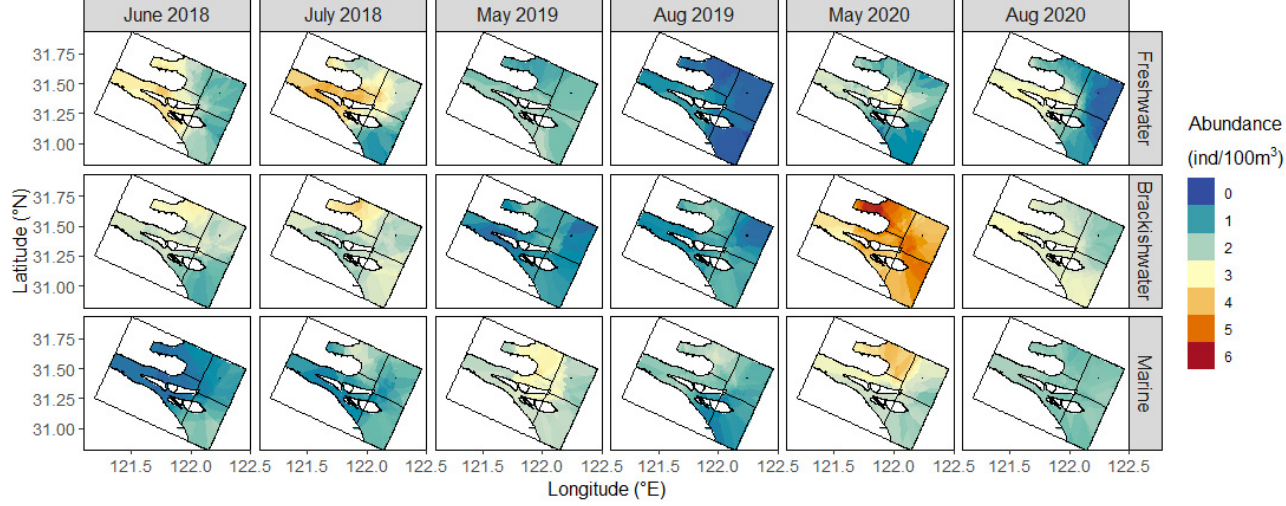
Figure 7. The distribution of abundance (log (ind./100 m 3 )) of larval fish of different ecological guilds.